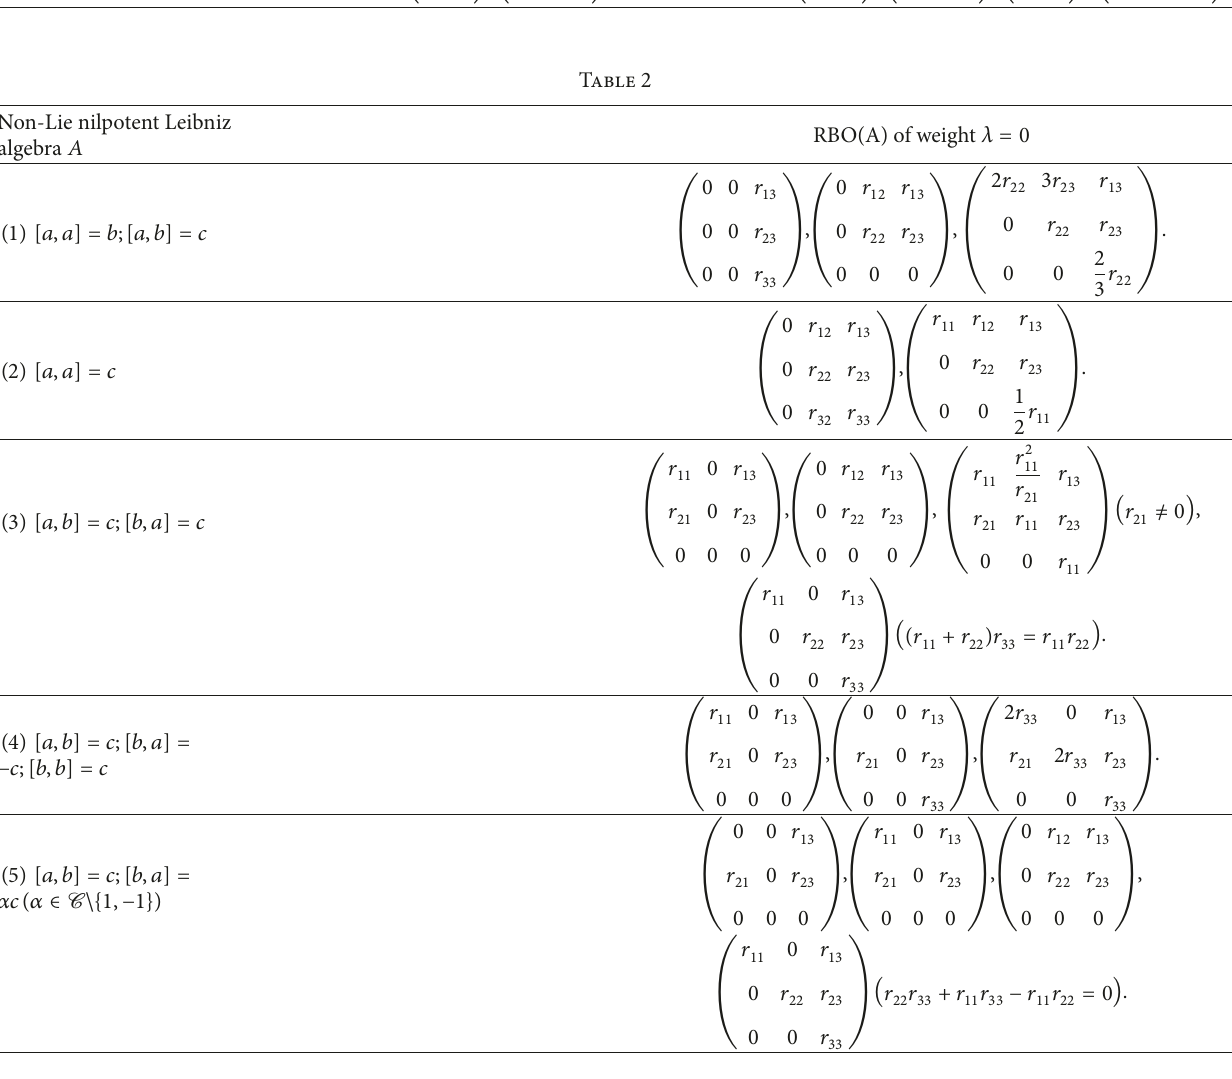
Non-Lie nilpotent Leibniz algebra 𝐴